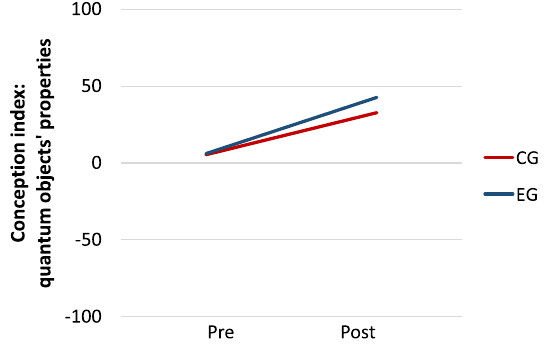
FIG. 6. We find a stronger increase of the mean conception index for quantum objects ’ properties and behavior from pre- to postsurvey in the experimental group than in the control